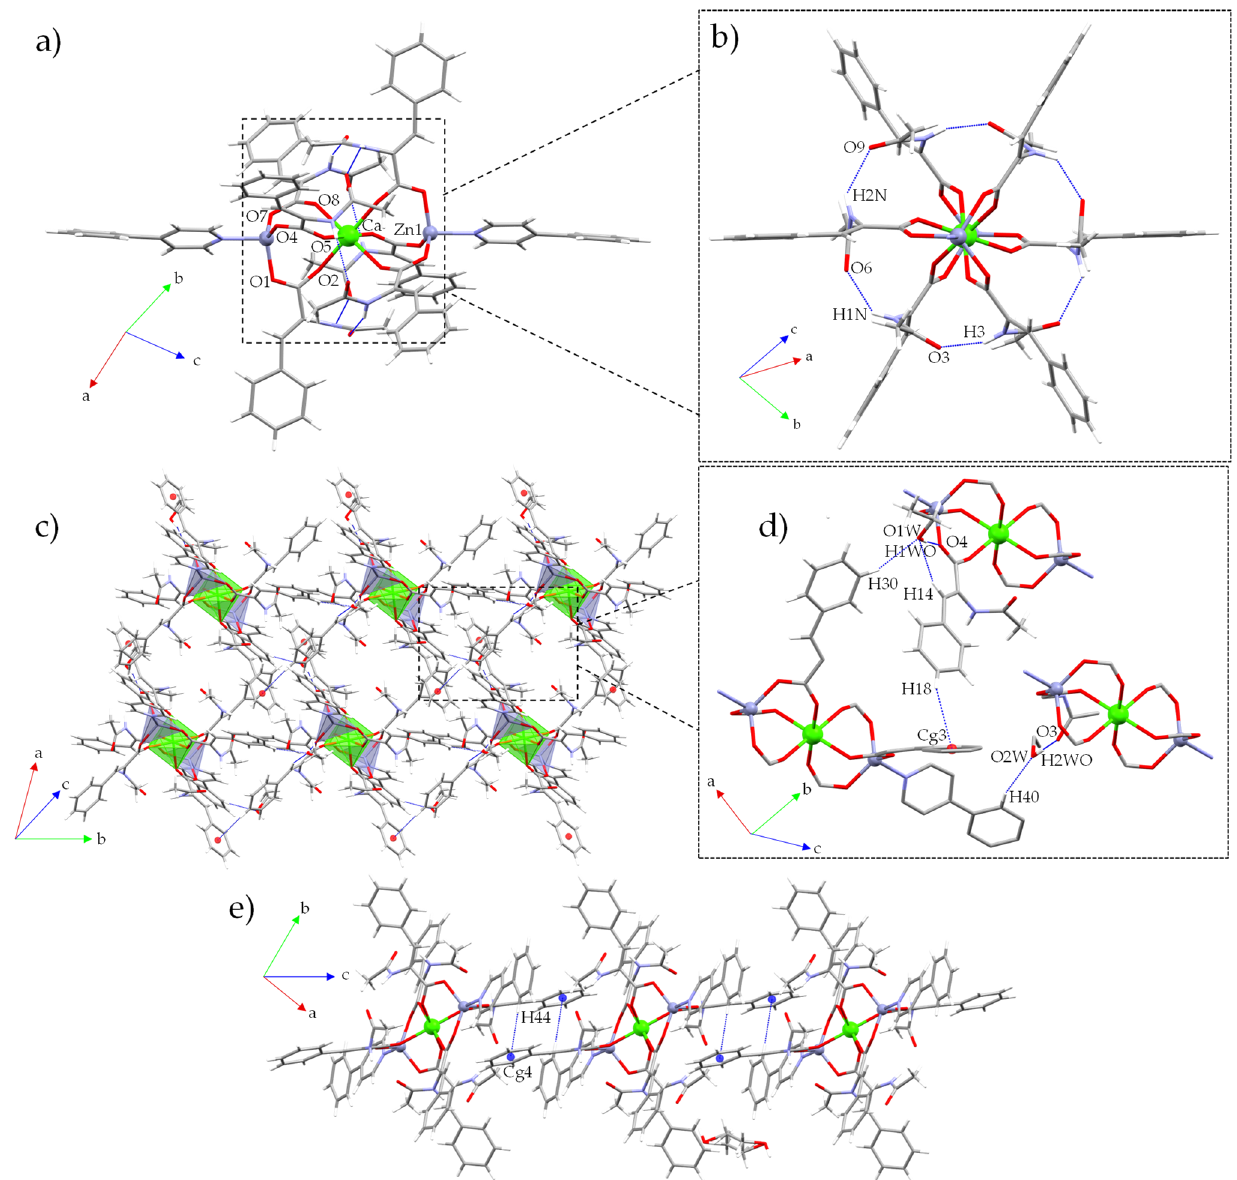
Figure 1. ( a ) Molecular structure of compound 1C . ( b ) Intramolecular interactions ( c ) Supramolecular expansion of 1C along the (002) plane. ( d ) In-detail view of the intermolecular interactions involved in the expansion along the (002) plane of 1C . ( e ) General view of the supramolecular expansion of 1C through the [001] direction.